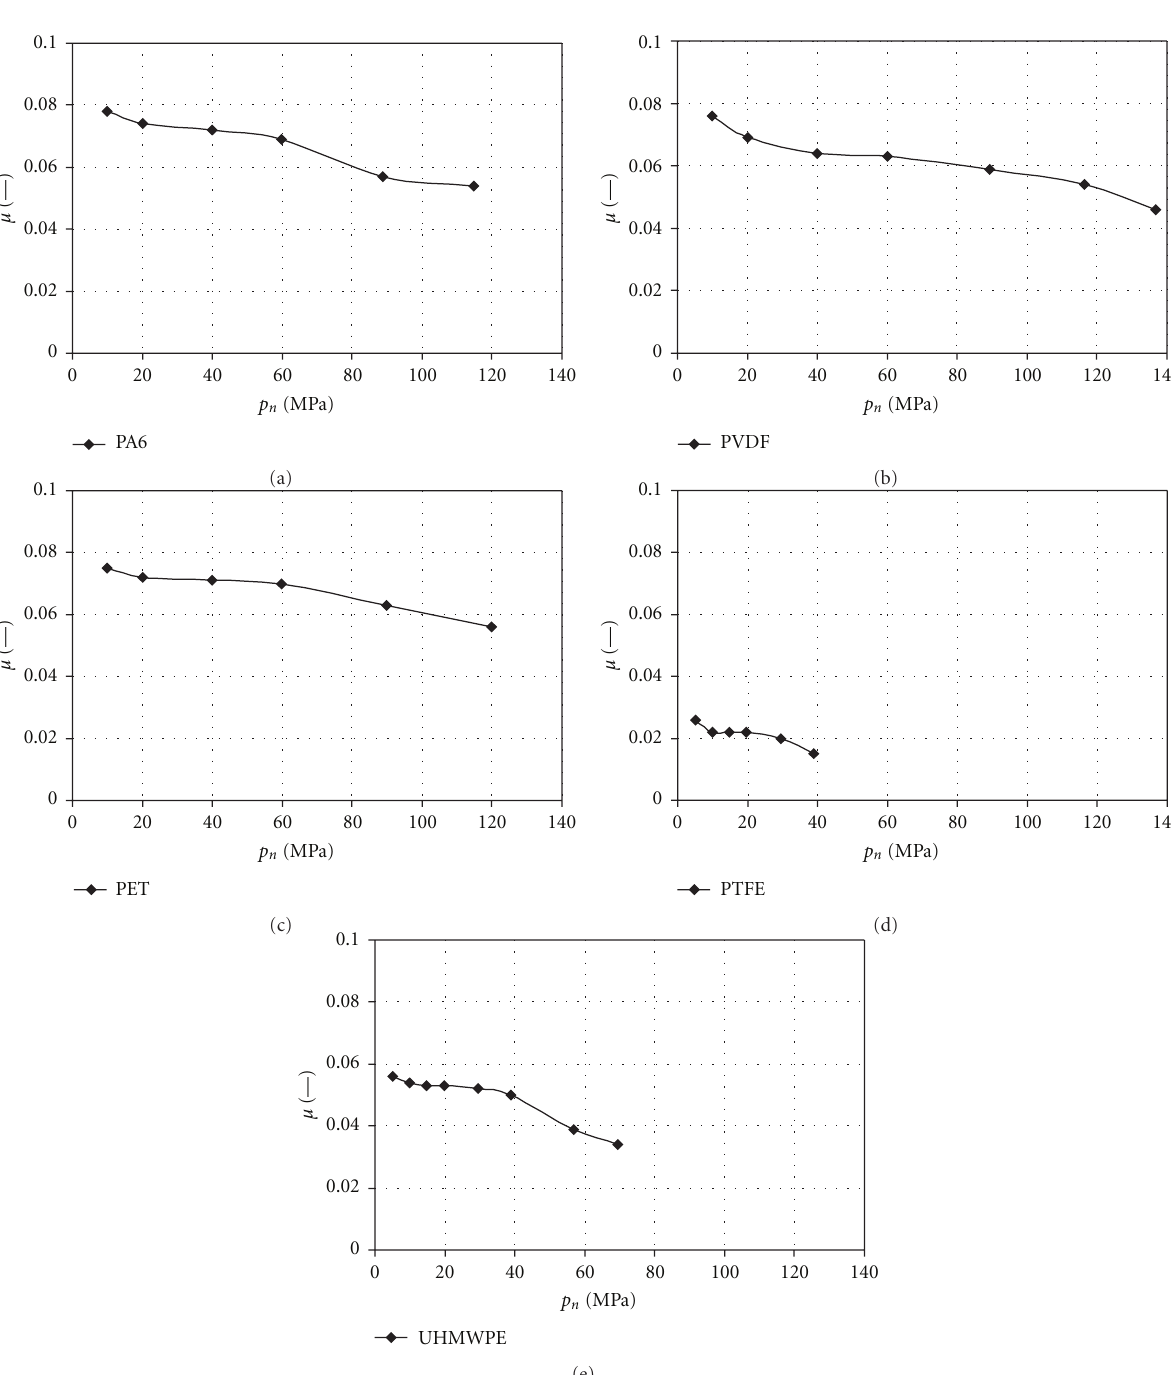
Figure 2: Experimental plots of the coe ffi cient of friction μ versus nominal contact pressure p n = F N /A n , for di ff erent polymers tested at 21 ◦ ± 1 ◦ C and 1mm/s